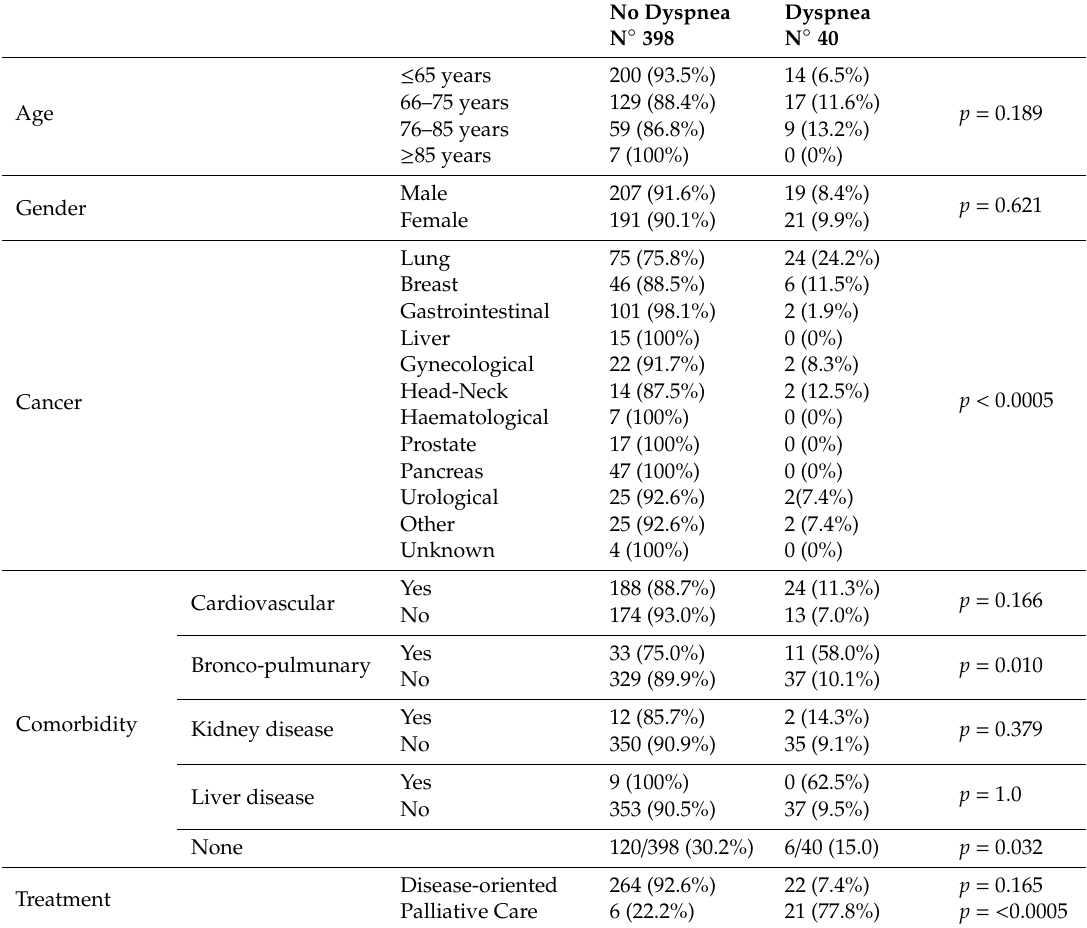
Table 1. Characteristics of patients screened for the study.